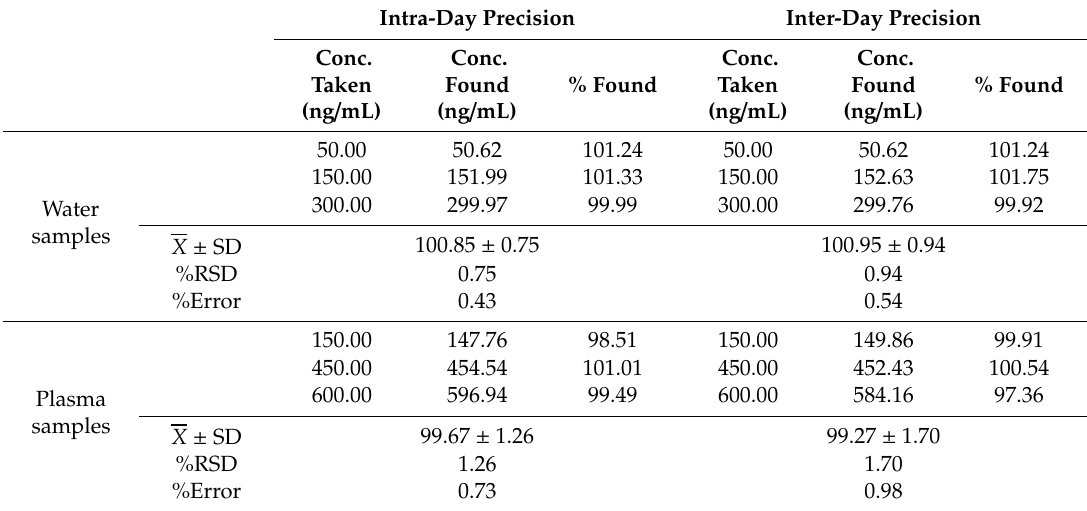
Table 3. Precision data for the determination of GEF in water and plasma samples by the proposed